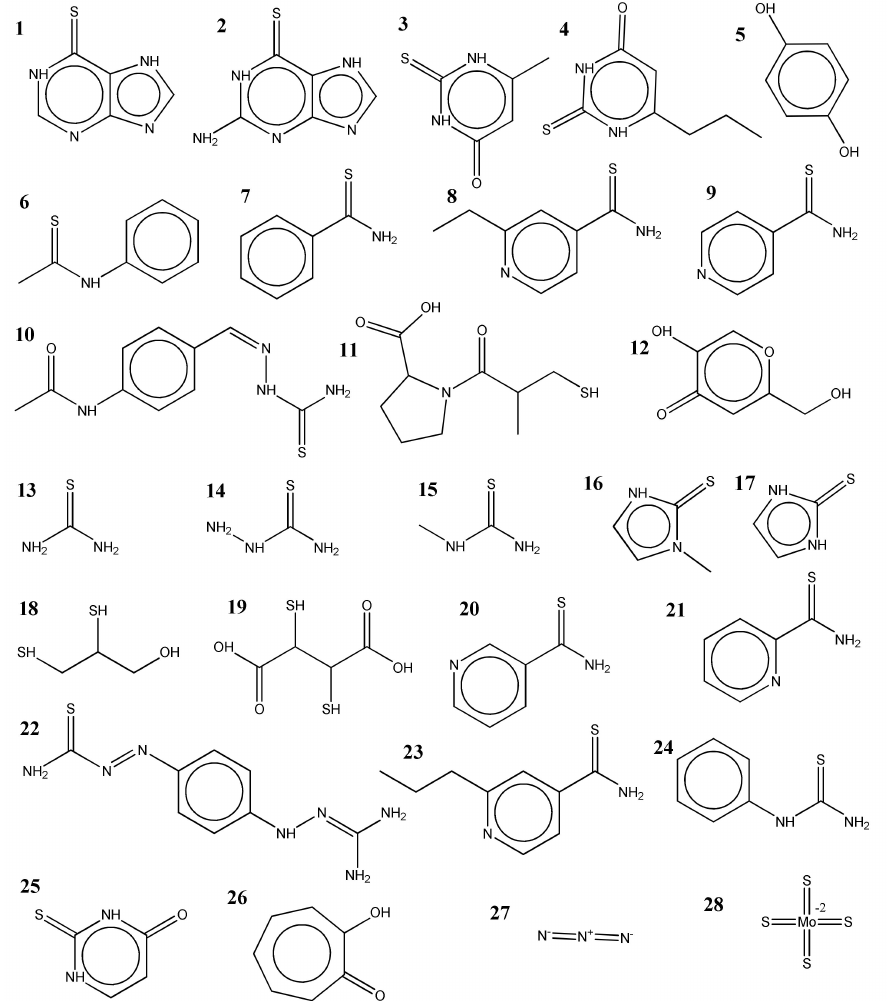
Figure 2. The molecules tested in this study were as follows: 1 . mercaptopurine, 2 .